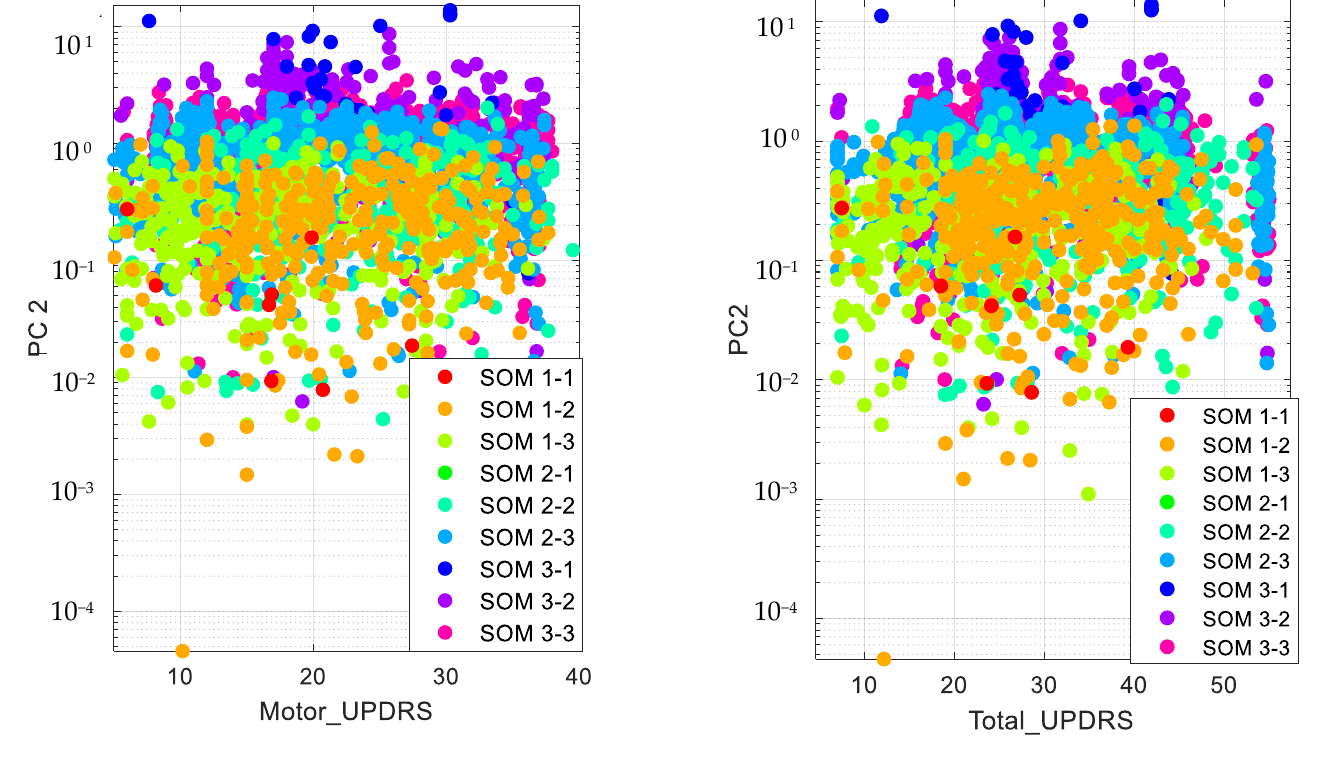
Figure 3. Visualizing SOM clusters. Table 3. Cluster centroids.